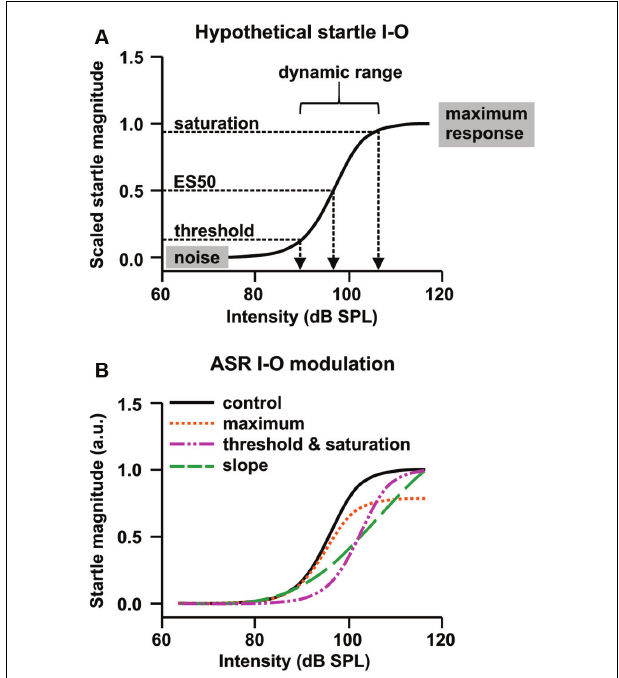
FIGURE 2 | Hypothetical plasticity of ASR input-output (I-O) functions. (A) The sigmoid function describing the relationship between startle stimulus (input) and startle response magnitude (output). The ASR threshold is a putative measure for ASR excitability, the efficient stimulus (ES) for the sound pulse potency, and the ASR maximum for motor capacity. Within the dynamic range of the I-O function, a small stimulus change can produce a large response change. The slope of the dynamic range can be used as metric for the reflex efficiency. (B) The control ASR I-O function (black solid line) could be altered through an increase or decrease in the maximum response to the loudest startle pulse (orange), a left- or right-shift of the curve, thereby increasing or decreasing ASR threshold, ES50, and saturation (pink), a steepening or flattening of the slope of the dynamic range of the function (green), or a combination of these effects (based on data and information from Hince and Martin-Iverson, 2005; Martin-Iverson and Stevenson, 2005). Normalization of the ASR I-O function to the individual startle magnitude at the loudest startle pulse allows analysis of threshold and slope without confounding effects of altered maximum